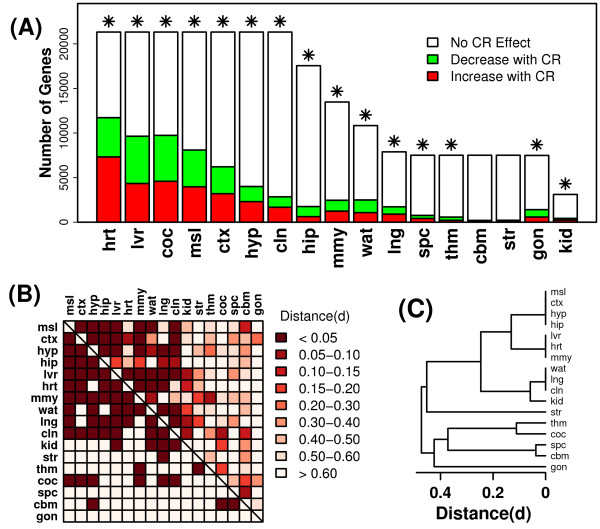
Differential expression patterns associated with caloric restriction. Differential expression signatures associated with CR in each tissue were generated based upon integration of results from one or several datasets (see Table 1). (A) The total height of each bar indicates the number of genes for which the effects of CR had been evaluated in at least one experiment (maximum of 21,327 genes). Colored sub-bars indicate the number of genes significantly up regulated (red) or down regulated (green) by CR within each tissue type (given a comparison-wise type I error rate of 0.05). Asterisk symbols (✴) indicate tissues for which a larger number of significant genes were identified than expected by chance. (B) The grid provides information on the pair-wise overlap between differential expression signatures associated with each tissue. The above-diagonal region is color-coded to reflect the distance between differential expression signatures (d). The value of d ranges from 0 to 1, where low values of d indicate that, between two signatures being compared, there exists an over-abundance of genes significantly regulated by CR in the same direction (see Methods). The region below the diagonal is coded in binary fashion, with dark squares indicating significant overlap between two differential expression signatures (P < 0.05) (see Methods). (C) An average linkage hierarchical cluster analysis was applied to differential expression signatures, where distance between signatures was based upon the measure d that is color-coded in the upper-diagonal region of the grid from part (B).